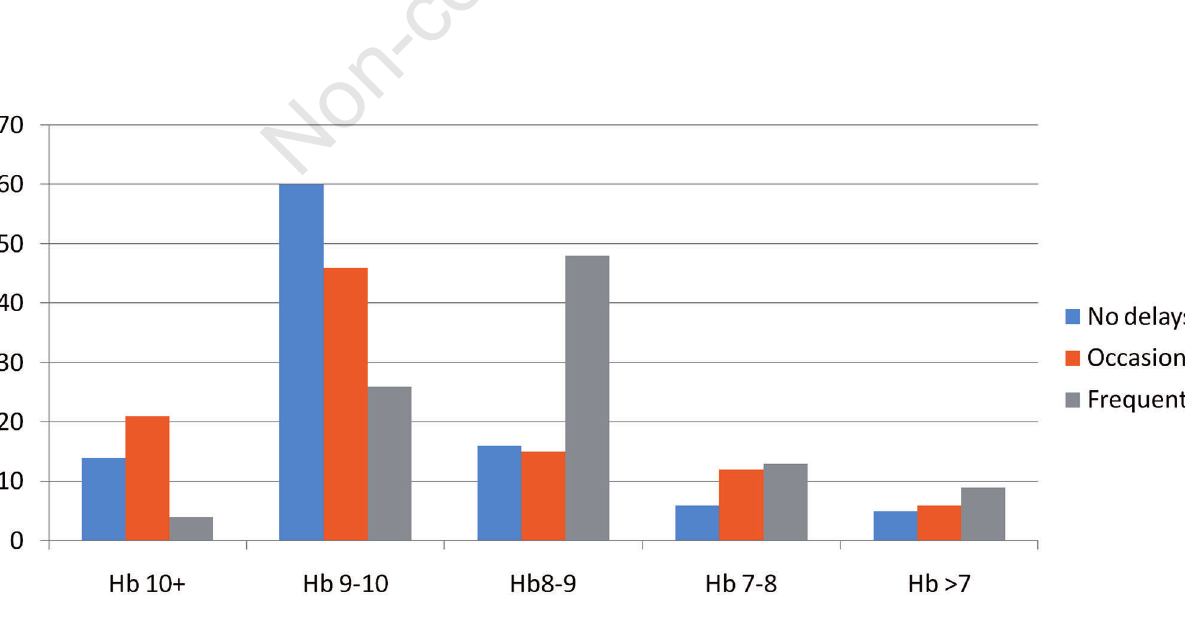
Figure 2. Classification of delays with respect to country